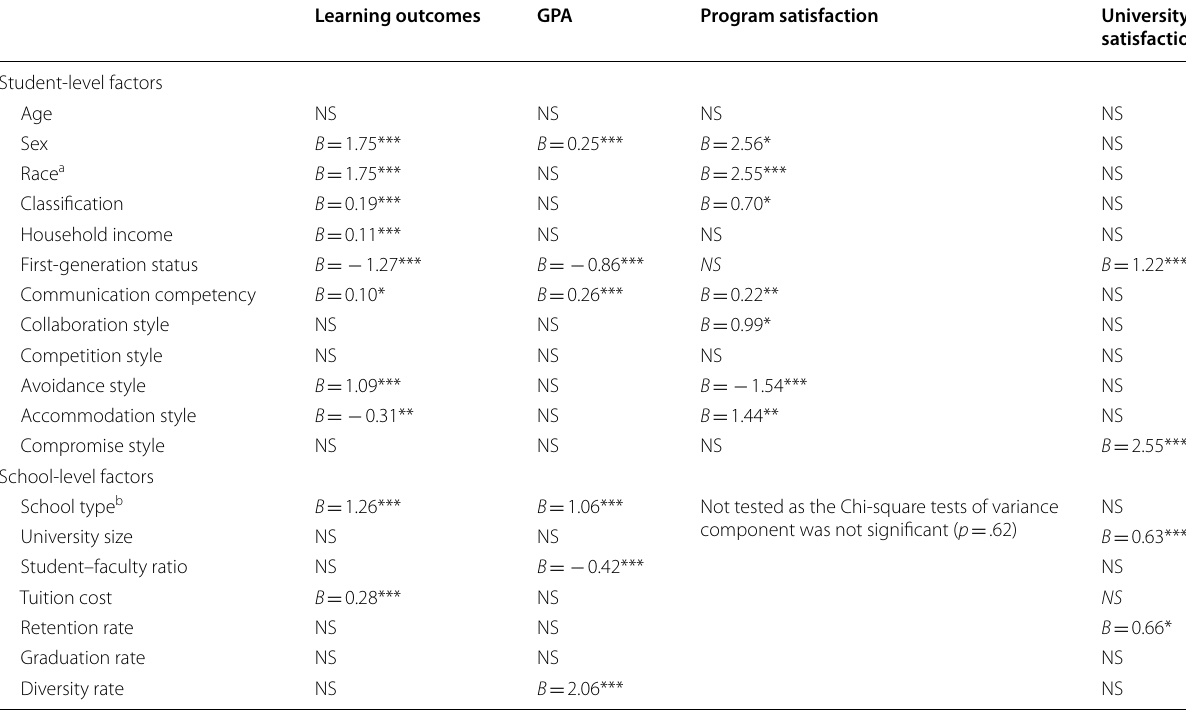
NS not significant and was removed using backward deletion a Minority students were coded as 1, White students were coded as 0 b Private schools were coded as 1, and all others were coded as 0 ***Indicates significant at 0.001 level, **indicates significant at 0.01 level, *indicates significant at .05 level